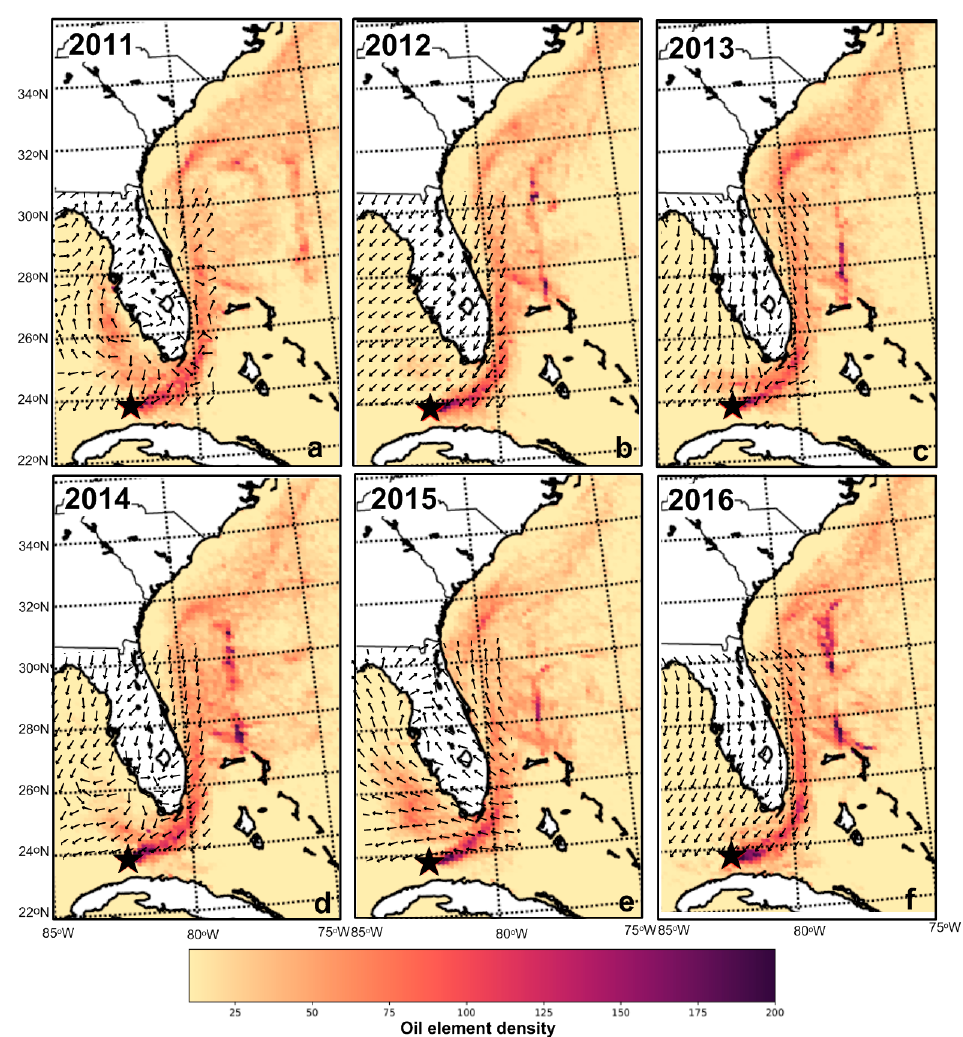
Figure 8. Same as Figure 5 but for Point 10 for ( a ) 2011, ( b ) 2012, ( c ) 2013, ( d ) 2014, ( e ) 2015, and ( f ) 2016. The superimposed vectors indicate the annual mean distribution of wind direction over WFS and EFS shelves derived from the ECMWF fields.